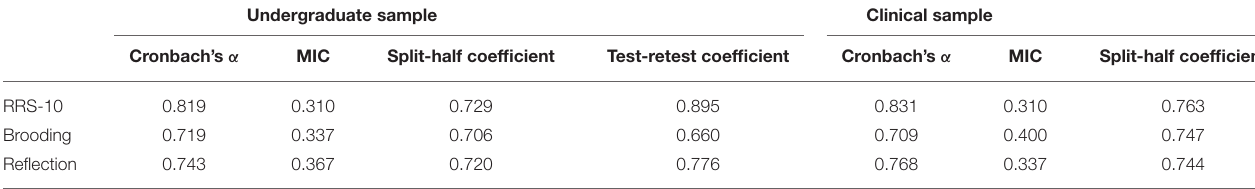
TABLE 1 | Cronbach’s α values, mean inter-item correlations, split-half reliability, and test-retest reliability of the RRS-10 and its two dimensions by sample.